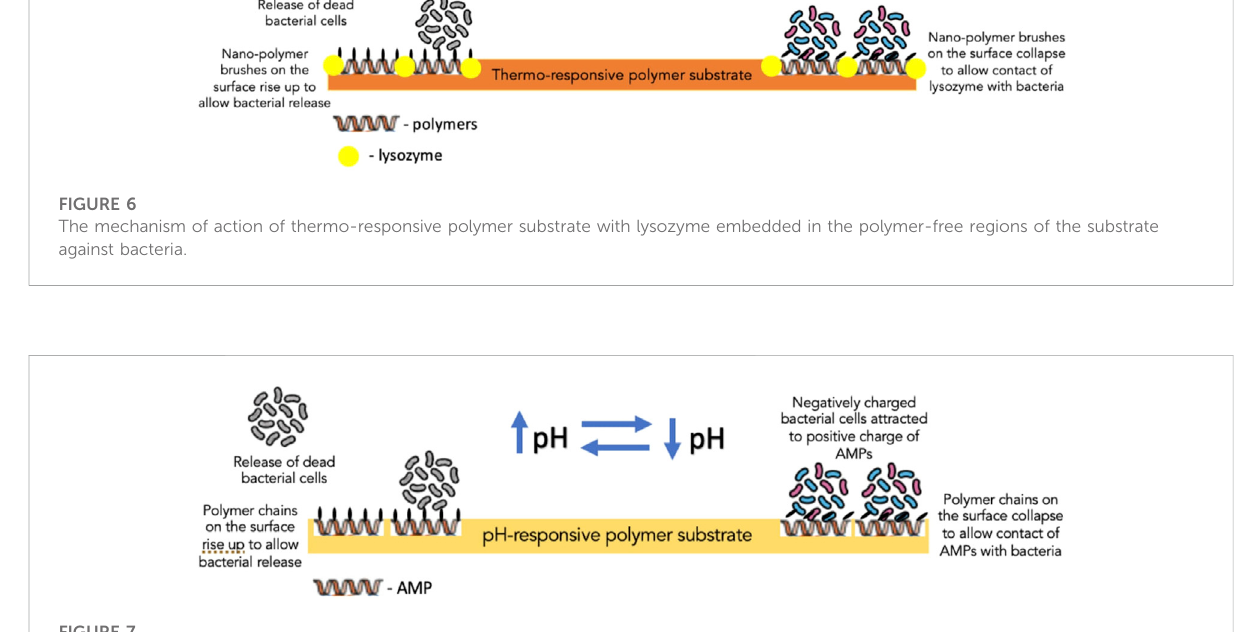
FIGURE 7 The mechanism of action of pH-responsive polymer substrate containing antimicrobial peptides in the inner layer of the